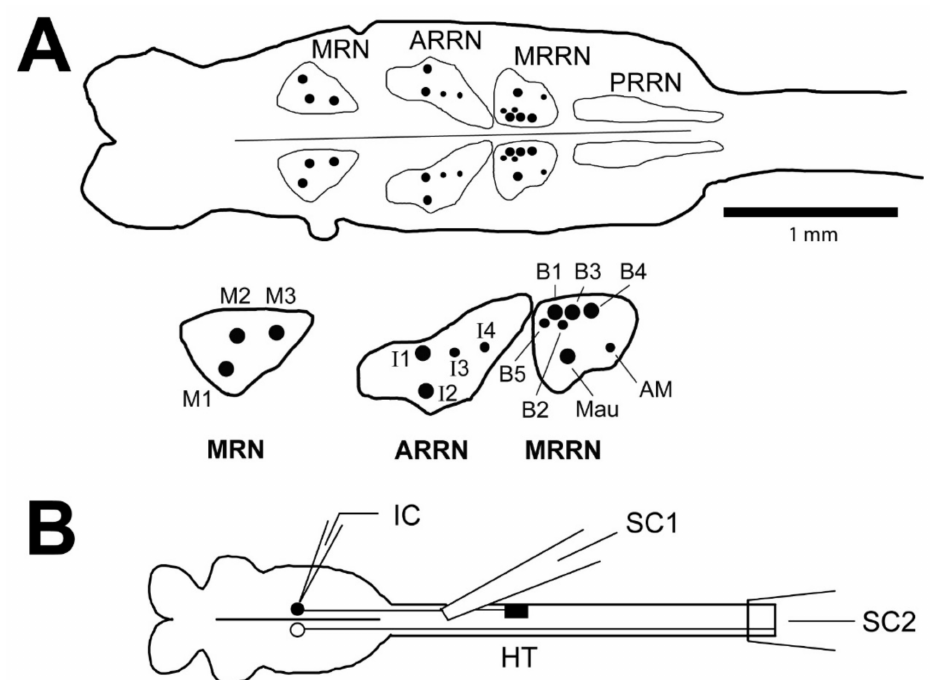
Figure 1. ( A ) (upper) Tracing of a larval lamprey brain (left) and rostral spinal cord (right) show- ing outlines around reticular nuclei: MRN=mesencephalic reticular nucleus; ARRN (anterior), MRRN (middle), and PRRN (posterior) rhombencephalic reticular nuclei. (lower) Enlargement of left reticular nuclei that contain large, uniquely identified reticulospinal (RS) neurons (Müller cells) that have ipsilateral projecting descending axons: M cells (M1-M3) in the MRN; I cells (I1-I4) in the ARRN; and B cells (B1-B5) in the MRRN. Mauthner (Mau) and auxiliary Mauthner (AM) cells are other identified RS neurons located in the MRRN that have contralateral projecting descending axons. In addition, all reticular nuclei (MRN, ARRN, MRRN, PRRN) contain numerous smaller, unidentified RS neurons that are omitted for simplicity. ( B ) Diagram of isolated brain-spinal cord preparation (not to scale), showing the brain (left) and rostral spinal cord (right), right spinal cord hemi-transection (HT) at 10% body length (BL, relative distance from the anterior tip of the head), and intracellular micropipette (IC) for recording from RS neurons. Spinal cord suction electrodes (SC1, SC2) were used to record RS neuron-evoked orthodromic action potentials rostral and caudal to spinal HTs to determine if a given neuron was injured ( • ) or uninjured